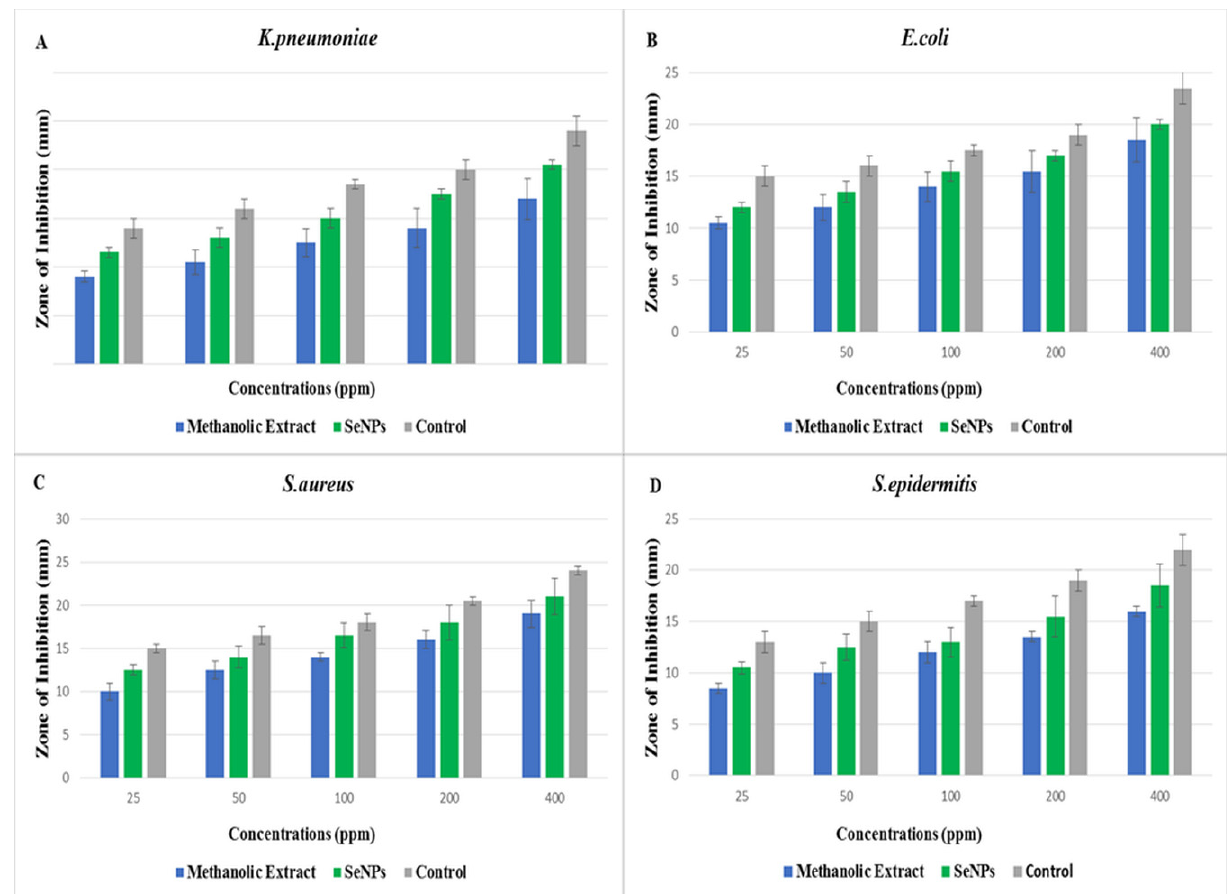
Figure 3. ( A ) Zone of inhibition of K. pneumoniae , ( B ) Zone of inhibition of E. coli. ( C ) Zone of inhibition of S. aureus , and ( D ) zone of inhibition of S. epidermitis.